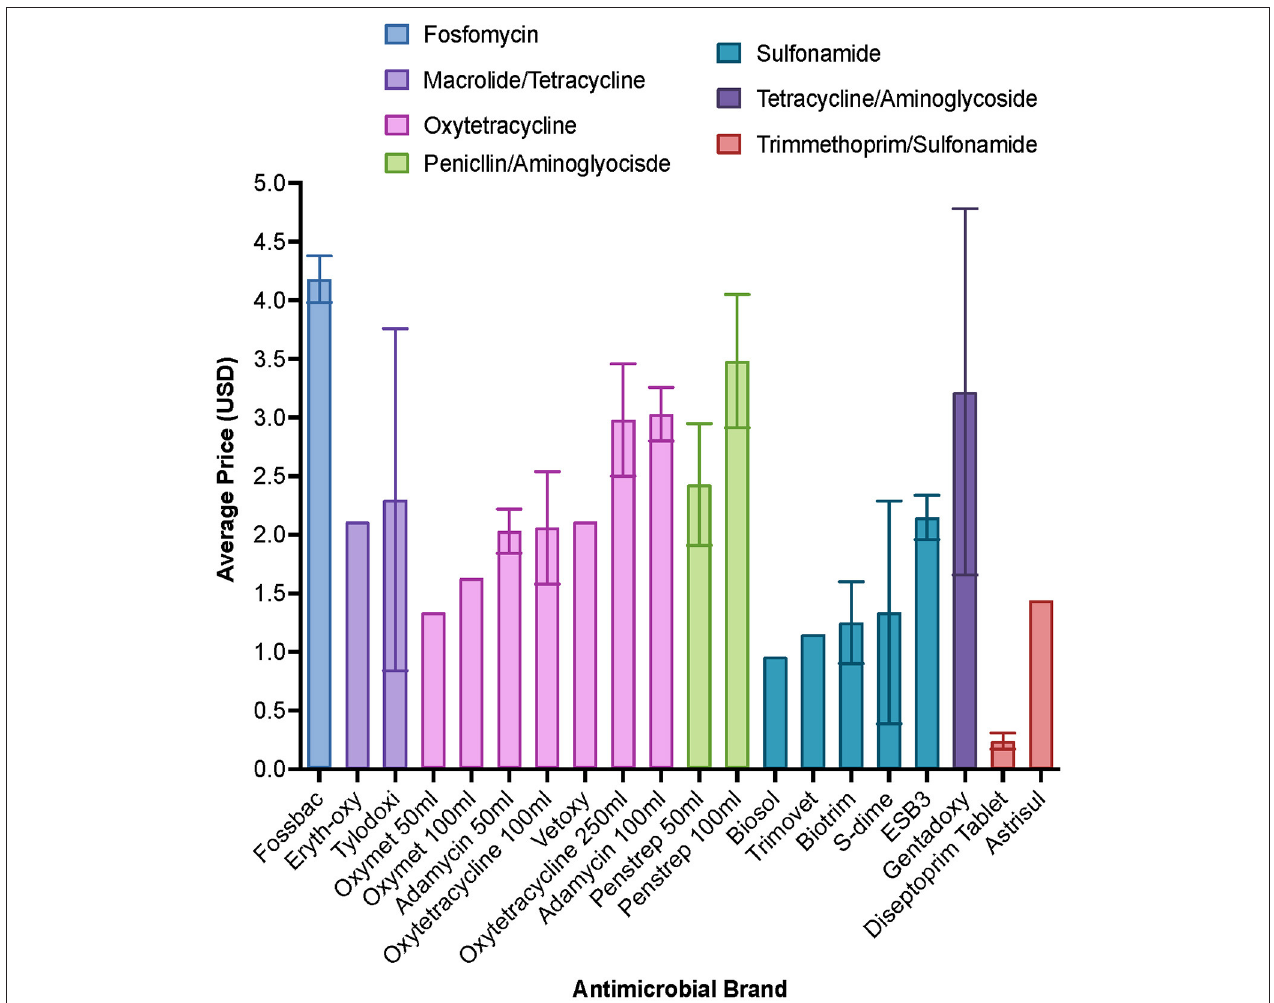
FIGURE 2 | Average sale cost of antimicrobials from 49 agrovet shops across Busia county. Error bars represent standard deviation where more than one agrovet shop reported pricing